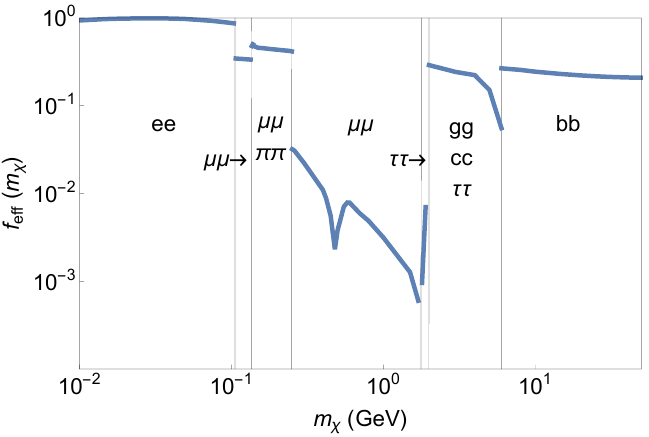
Figure 3 . The efficiency of the deposited energy from dark matter annihilation to be injected into the primordial plasma is depicted by a solid line. The letters in the figure show the dominant anni- hilation mode in each mass regions (except the intermediate mass region, 500 MeV ≤ m φ ≤ 4 GeV).